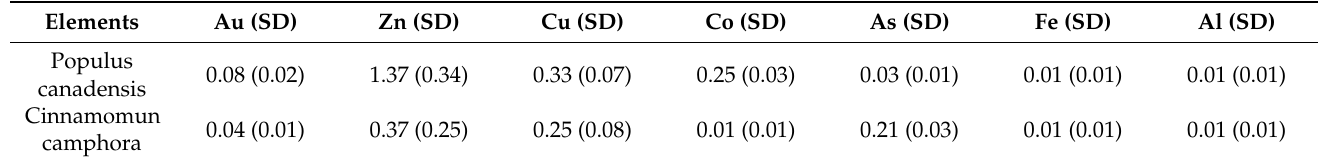
Table 3. Biological absorption coefficient of dominant